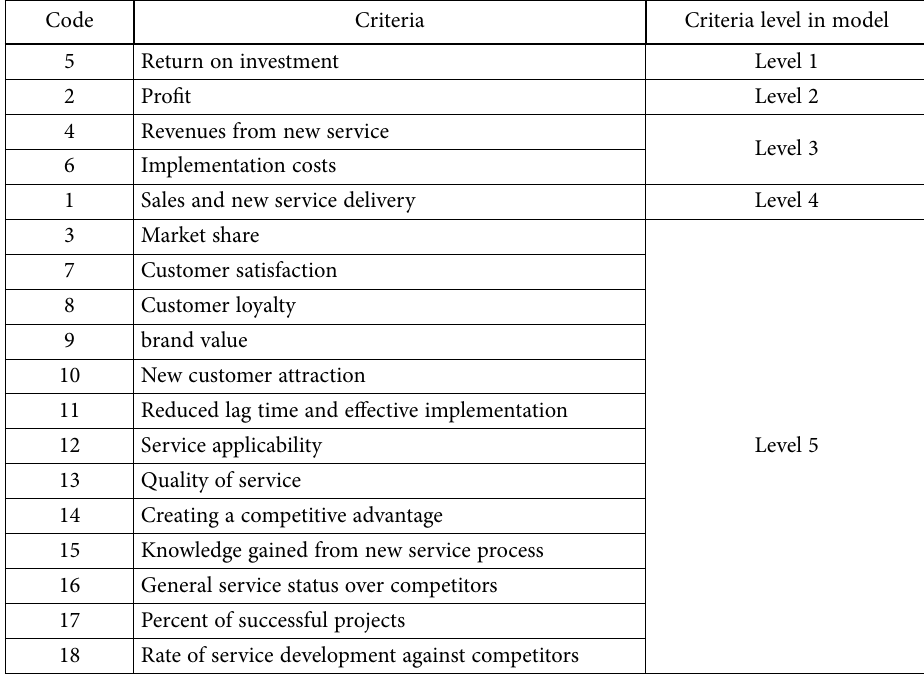
Table 6. Levels assigned to